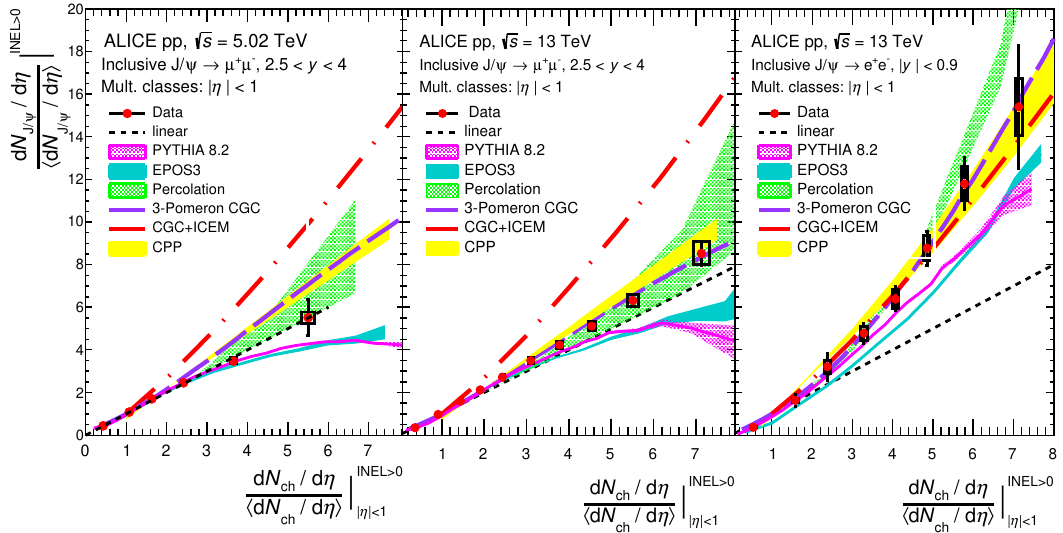
Figure 7 . Comparison of the relative J /ψ yield as a function of the relative charged-particle density with model predictions: CPP [58], CGC with ICEM [59], 3-Pomeron CGC [60], Percolation [61], EPOS3 event generator [57], and PYTHIA 8.2 [43] at forward rapidity in pp collisions at (left) and 13 TeV (middle). The right hand side figure shows the results from midrapidity compared to the corresponding theoretical model estimations for pp collisions at